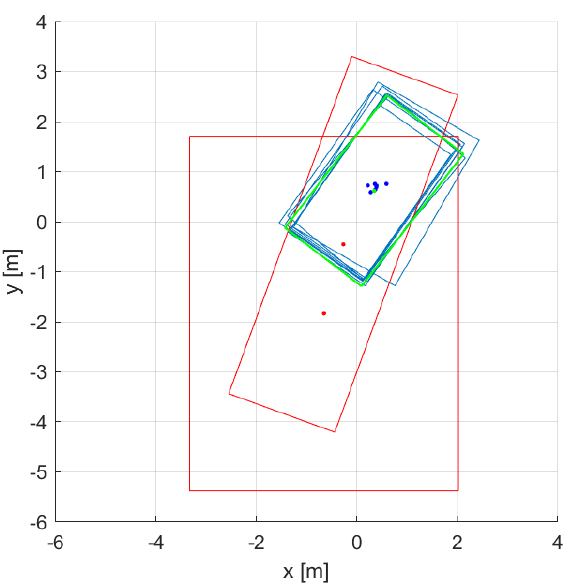
Figure 9. Example of outlier detection and integration of the MBBs (2D-view from above, red: outliers, blue: remaining MBBs, green integrated MBB)